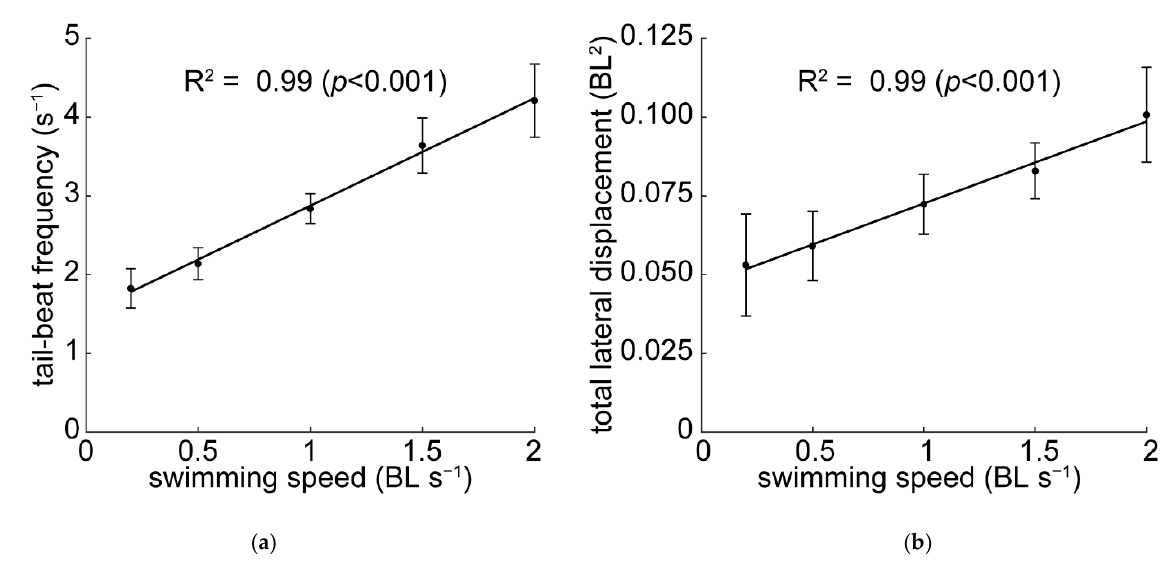
Figure 3. Tail-beat frequency and amplitude envelope area. ( a ) Mean tail-beat frequency (f) measured at the tip of the tail shows a strong linear relationship with swimming speed (U) in the form of f = α U + β where α = 1.366 BL − 1 and β = 1.509 s − 1 (R 2 = 0.997; r = 0.998; p < 0.01). ( b ) The relationship between mean amplitude envelope area A (normalized to BL 2 ) and swimming speed is expressed as A = γ U + δ where γ = 0.026 BL s and δ = 0.047 BL 2 (R 2 = 0.991; r = 0.995; p < 0.01). Error bars represent standard deviation. Table 1. Kinematic parameters. Means ± s.d. of kinematic parameters for steady swimming at speeds ranging from 0.2 to 2.0 BL s − 1 and p -value results of ANOVA F-test (number of fish = 7). Parameters showing no significant difference across swimming speeds are indicated with the same superscript letters.